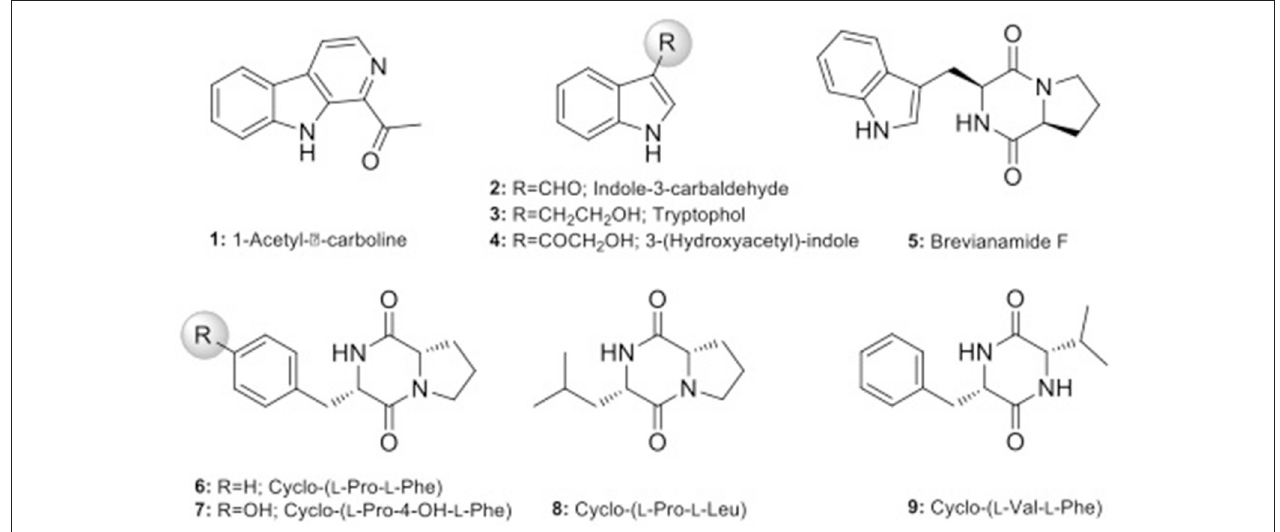
FIGURE 9 | Chemical structure of compounds isolated from strain Aeromicrobium ponti LGMB491.